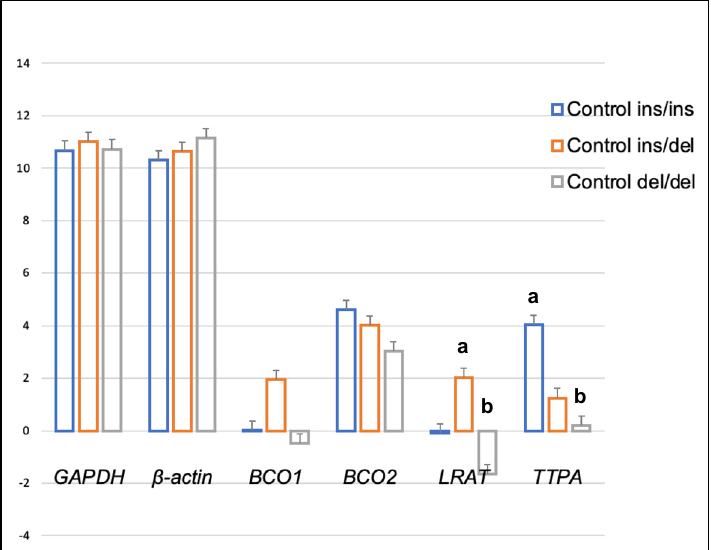
Figure 1. Relative BCO1 , BCO2 , LRAT, and TTPA mRNA levels (log2 abundance) in the perirenal fat of rabbits with different genotypes at codon 248 of the BCO2 gene (ins/ins vs. ins/del vs. del/del) fed the control diet. GAPDH and ß ‐ actin were used as reference genes. Data represent posterior means (expressed as arbitrary units) ± SEM (standard error of the mean). Means followed by the different superscripts (a, b) differ significantly ( p ≤ 0.05).